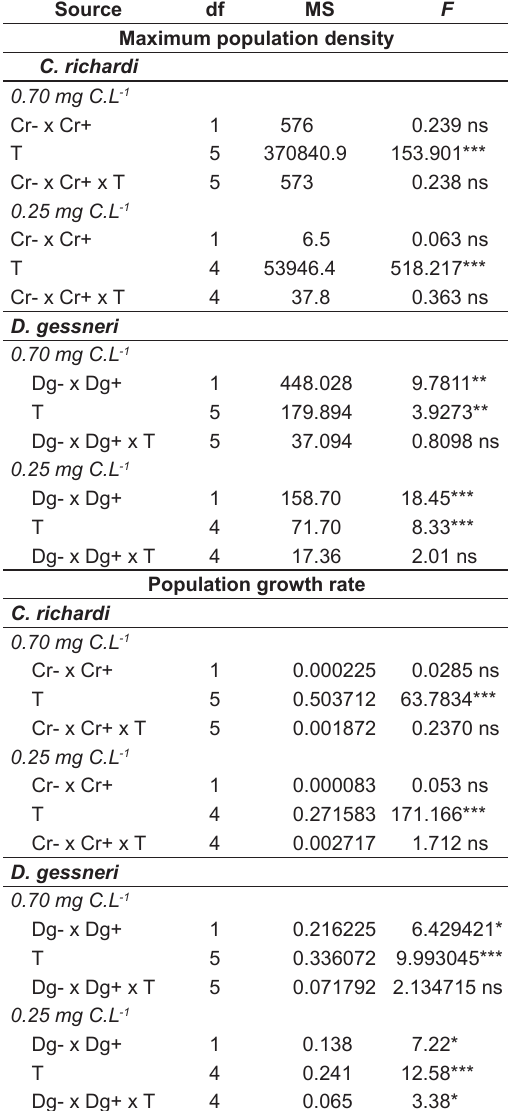
Table 2. One-way repeated-measures ANOVA for the treatment effects, with species C. richardi and D. gessneri , alone (Cr- and Dg-) or mixed (Cr+ and Dg+), and the effect of time (T) on density and population growth